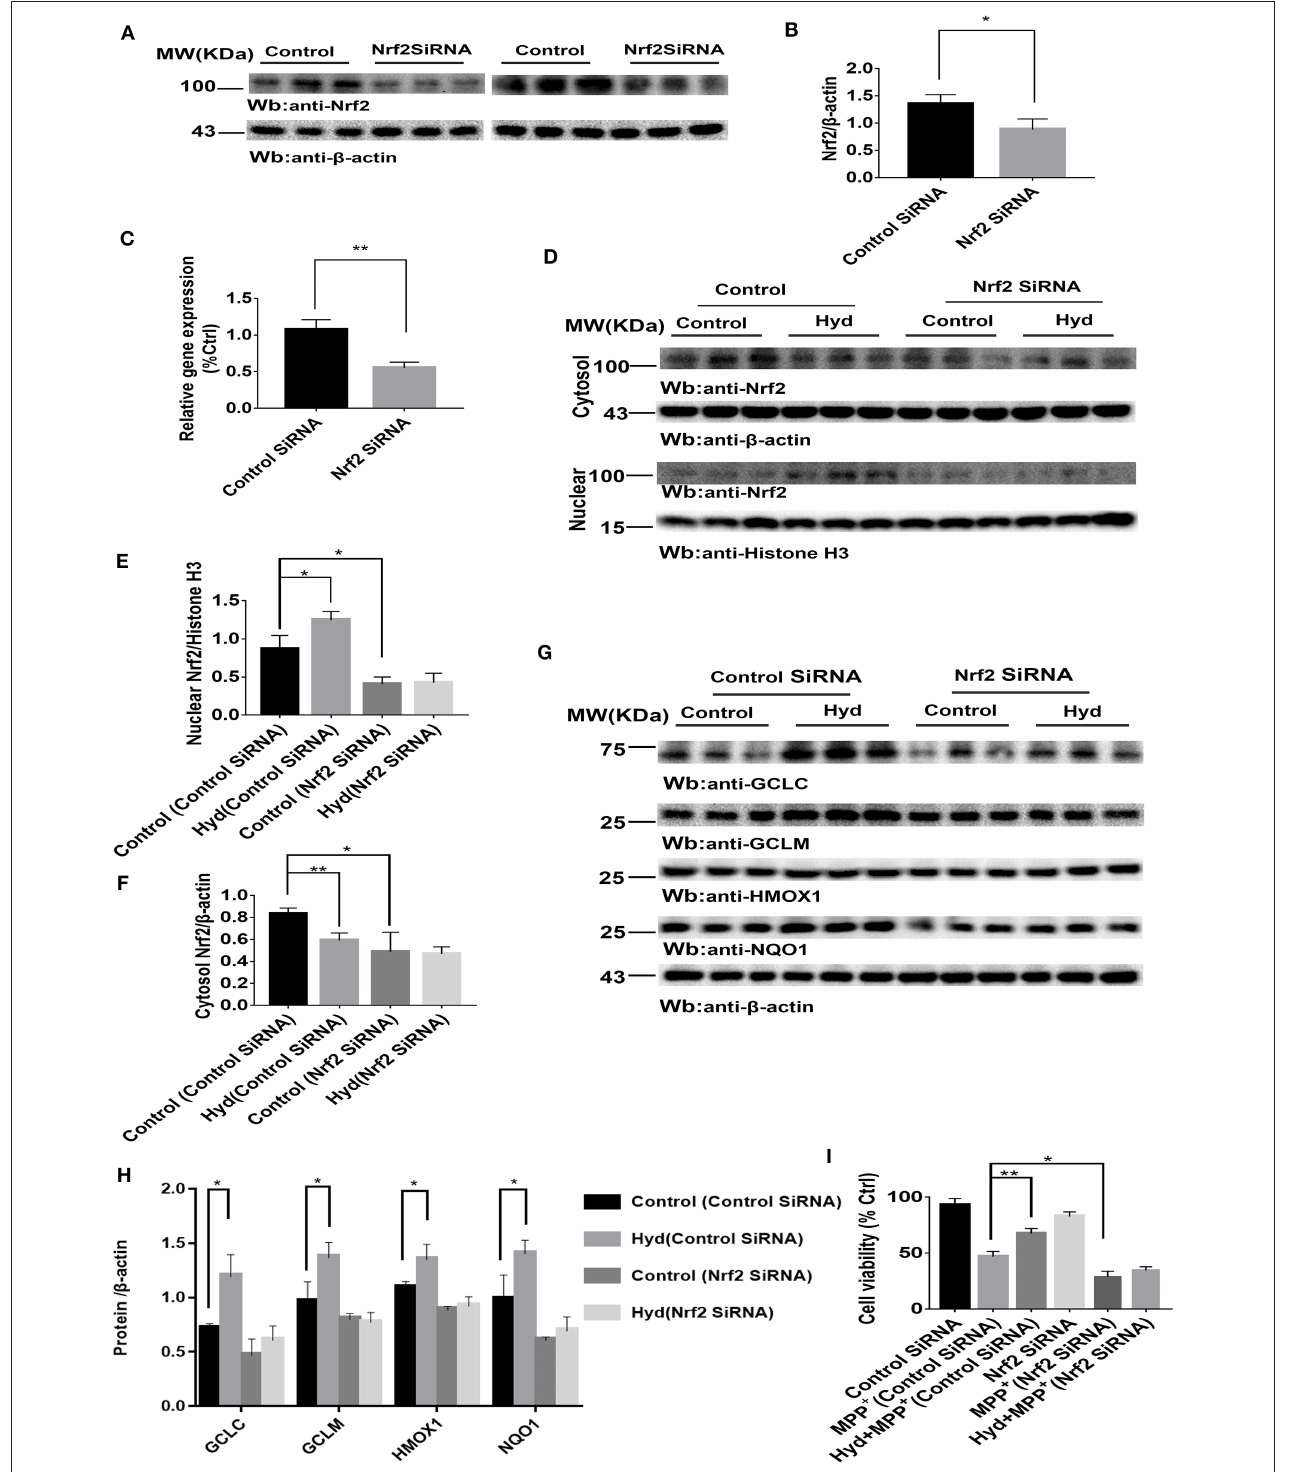
FIGURE 2 | Hydralazine activate Nrf2-ARE signaling and attenuate MPP + -mediated cytotoxicity in an Nrf2-dependent pattern. SH-SY5Y cells were treated with either an Nrf2 SiRNA or a control SiRNA. The protein and mRNA levels of Nrf2 were measured by western blotting and real-time PCR (A–C) . * p < 0.05, ** p < 0.01, n = 6, significant difference between the two indicated groups. Hydralazine treatment alone induced a remarkable increase in the nuclear translocation of Nrf2, however, Nrf2 interference abolished the increase in nuclear Nrf2 induced by hydralazine in SH-SY5Y (D,E) , in the meantime, cytosolic Nrf2 had corresponding decrease in contrast